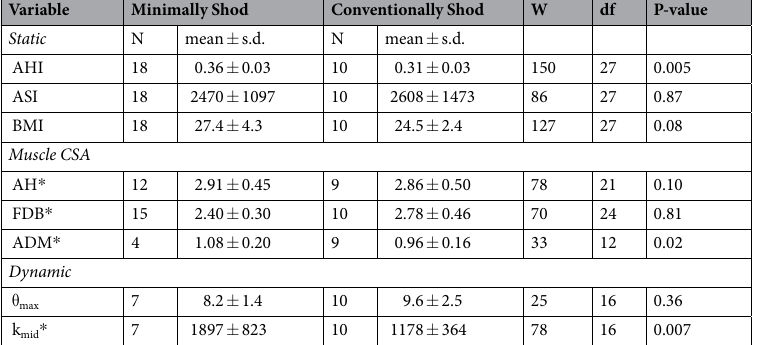
Table 3. Means and standard deviations for study variables in physical activity-matched sub-samples, and results of Wilcoxon rank sum tests between minimally and conventionally shod participants. * For statistical tests, these variables were scaled by dividing by (body mass) 0.67